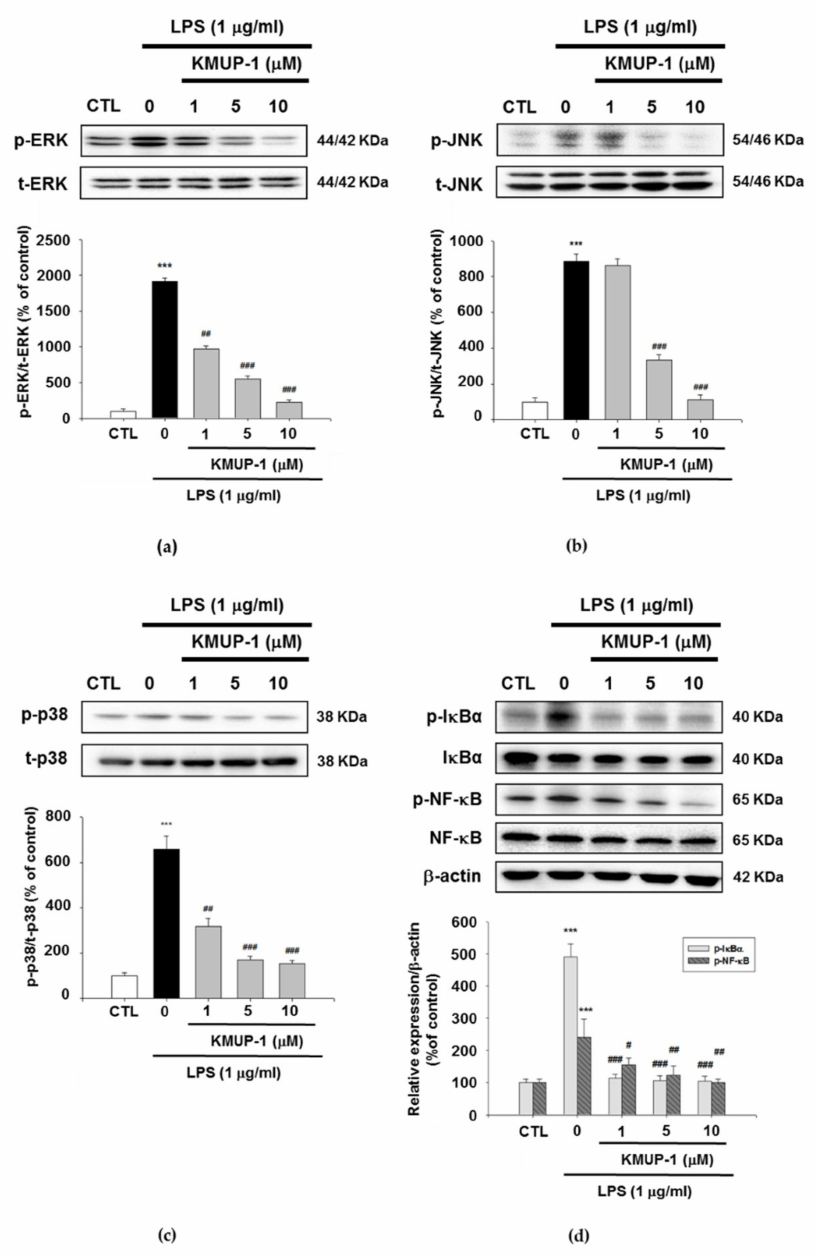
Figure 5. Effects of KMUP-1 on MAPK and NF- κ B expressions of LPS-induced RAW 264.7 cells. A representative Western blots demonstrating ( a ) ERK phosphorylation levels, ( b ) JNK protein levels, ( c ) p38 protein levels, and ( d ) I κ B α and NF- κ B expression levels. Values are presented as mean ± SEM, n = 3. *** p < 0.001 compared to control group. # p < 0.05, ## p < 0.01, ### p < 0.001 compared to LPS